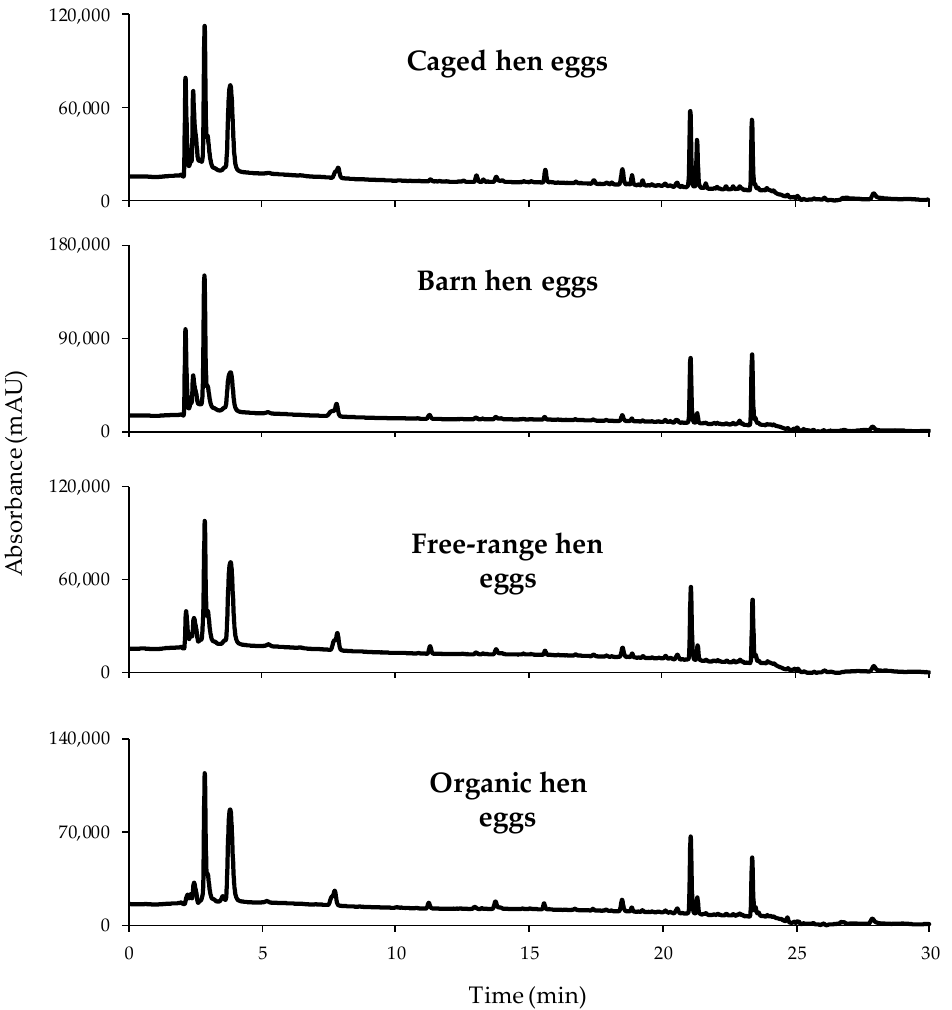
Figure 2. Highperformanceliquidchromatographywithultravioletdetection(HPLC-UV)chromatographic Figure 2. High performance liquid chromatography with ultraviolet detection ( HPLC-UV) fingerprints acquired at 250 nm for a selected sample within each egg chromatographic fingerprints acquired at 250 nm for a selected sample within each egg type.